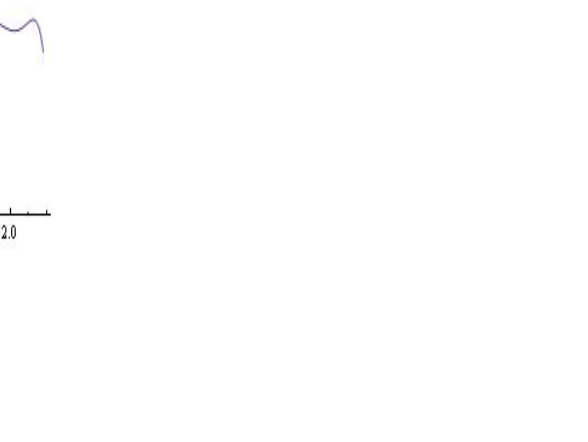
Figure 14. Application for modeling and analysis of electrical circuits and signal processes.